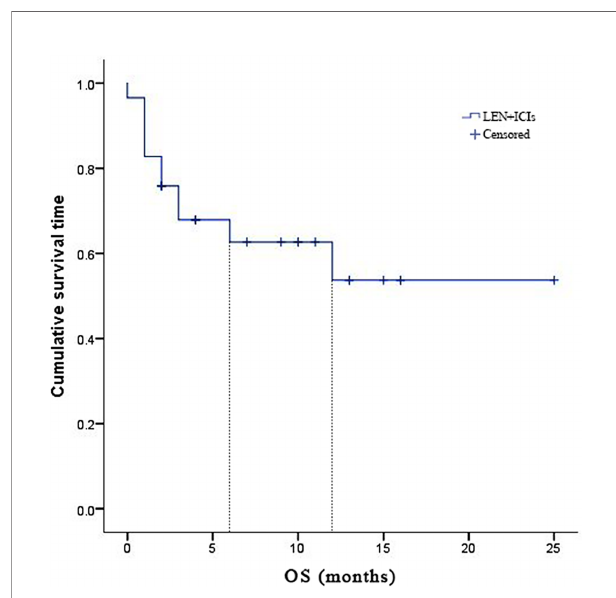
FIGURE 2 | Kaplan-Meier estimates of over survival for 27 eligible patients with advanced hepatocellular carcinoma who were treated with lenvatinib plus immune checkpoint inhibitors.